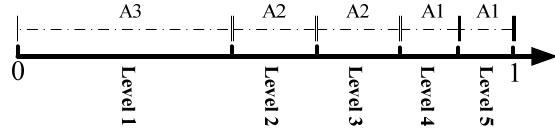
Figure 3. Roulette-wheel Figure 3. Roulette ‐ wheel selection.